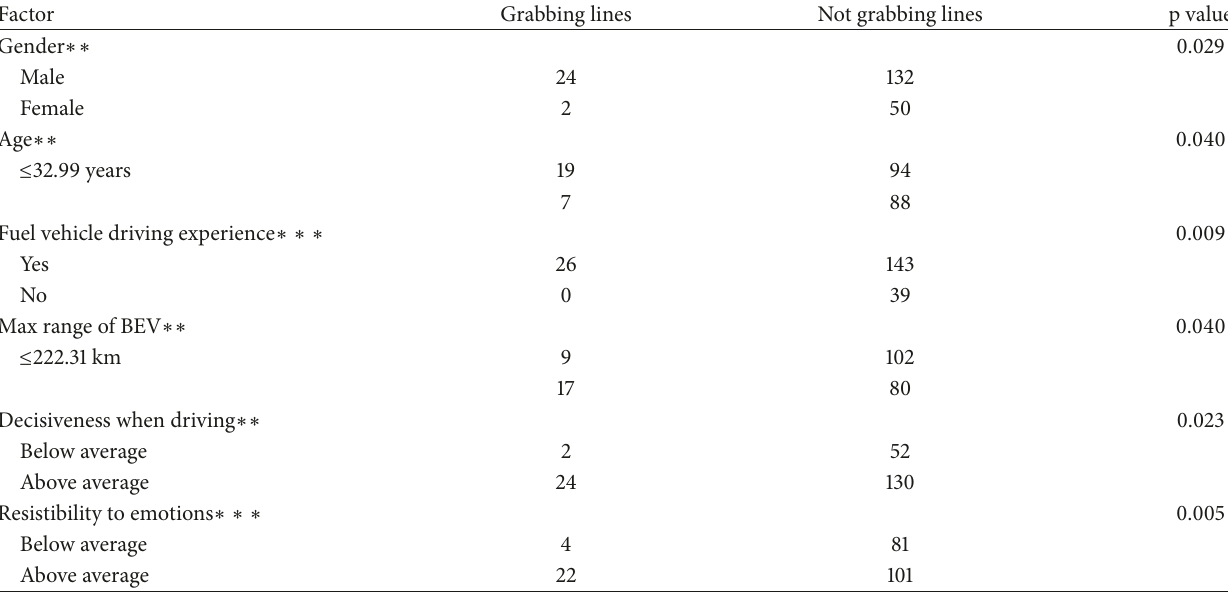
Table 7: Chi-square test results of factors that may be related to grabbing lines